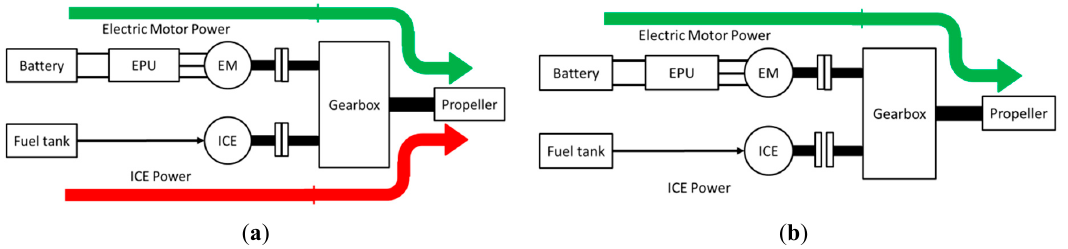
Figure 1. Functional scheme of the parallel hybrid propulsion architecture under analysis: ( a ) power boost conditions; ( b ) green taxi operations.